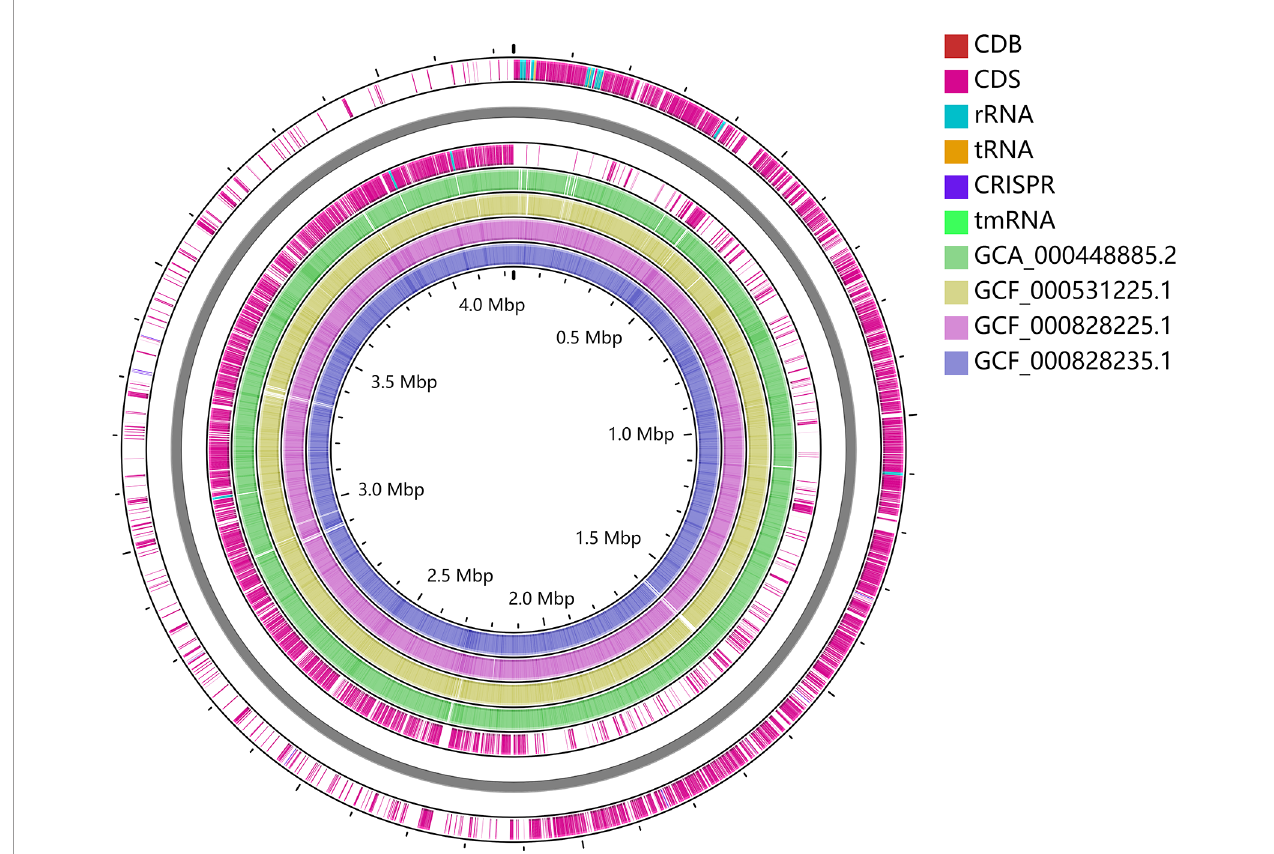
FIGURE 4 | Whole-genome alignment of CDB with four reference C. dif fi cile ST54 strains obtained from the public database. The circular genome has been generated using